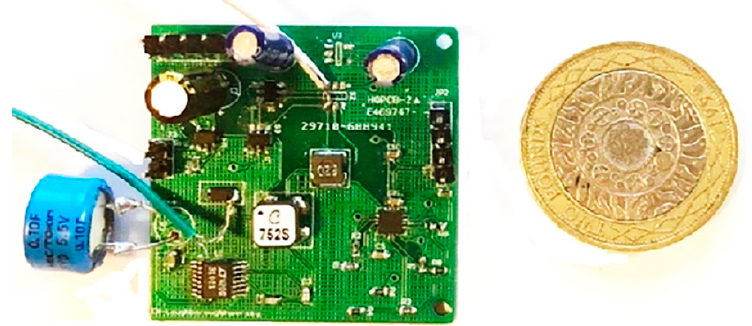
Figure 8. Established PMS circuit (Compared with two-pound coin).